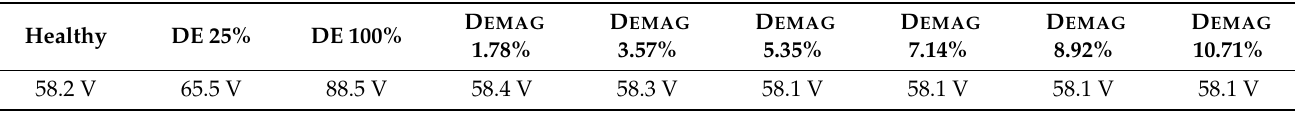
Table 5. Largest peak value of E AB in one mechanical period under different conditions (for 9-slot and 8-poles motor at 1000rpm).